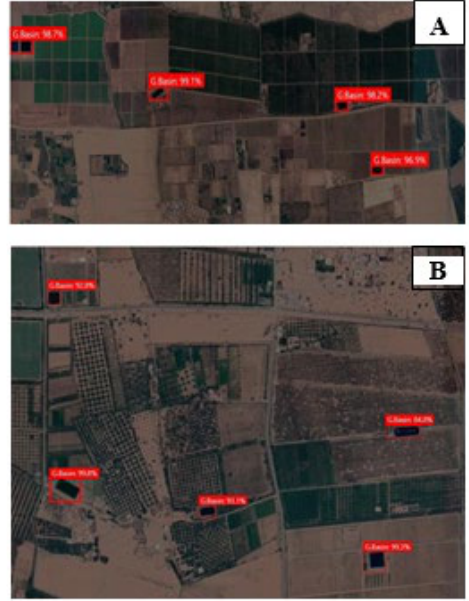
Figure 8. A,B: Geomembrane basins detection results.